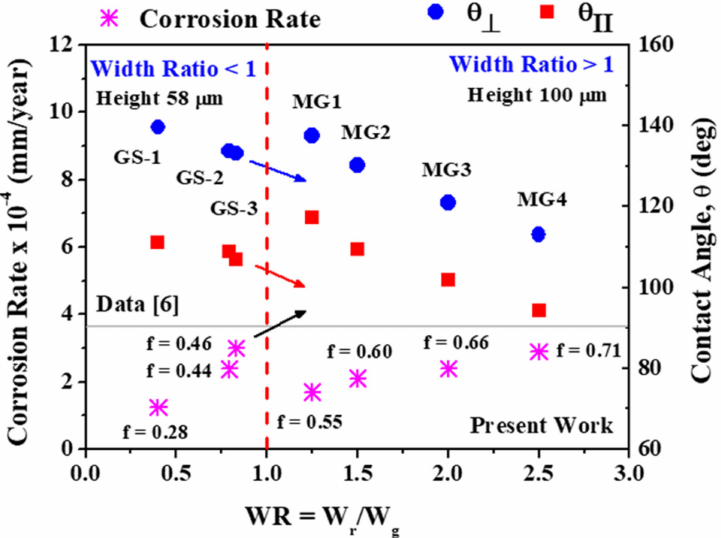
Figure 11. Water contact angles ( θ ⊥ , θ Π ) and corrosion rate of GS microgrooves (WR < 1) (data from [6]) and MG (WR > 1, present work, prior to long-term exposures to 3.5 wt. % NaCl solution). Solid fraction (f) of the GS and MG are mentioned near their respective corrosion rate data